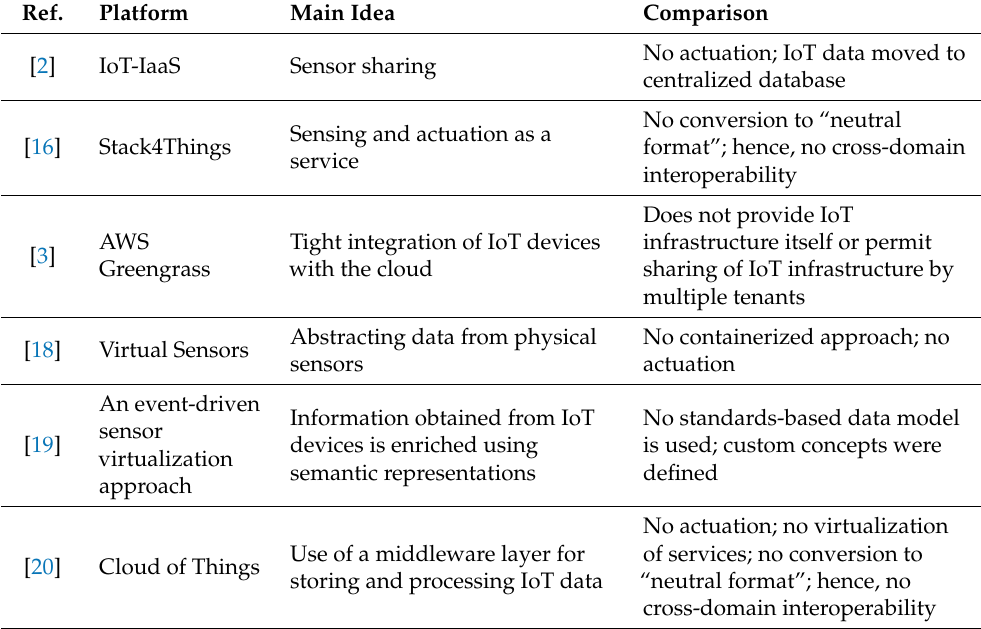
Table 1. Summary of related works.